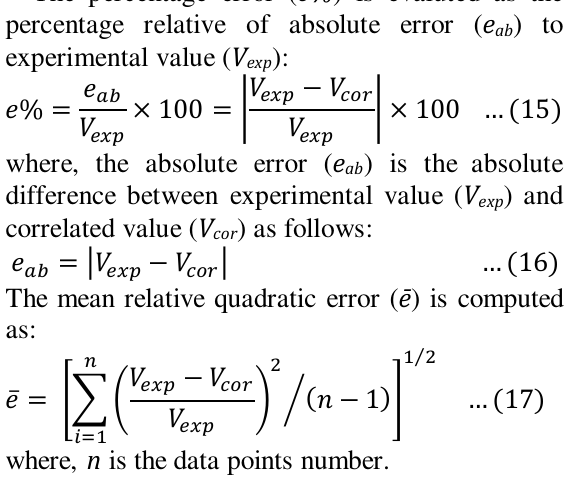
temperatures difference and surface heat flux for the continuous